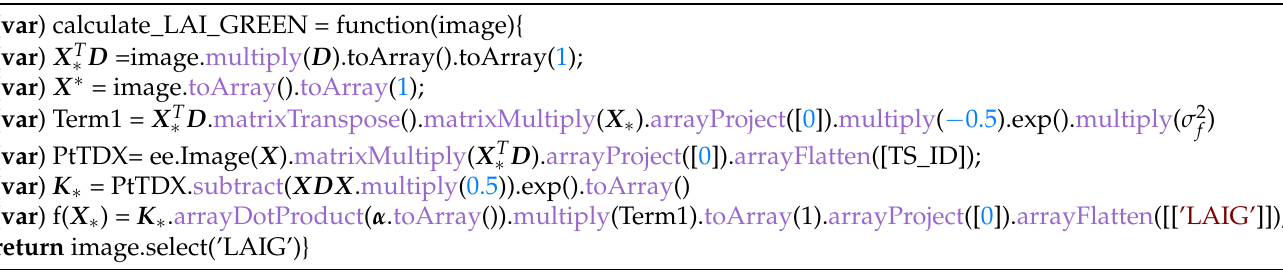
Table 5. Lines of pseudo-code of GPR core implementation in Google Earth Engine (GEE) with mathematical notation for variable easy